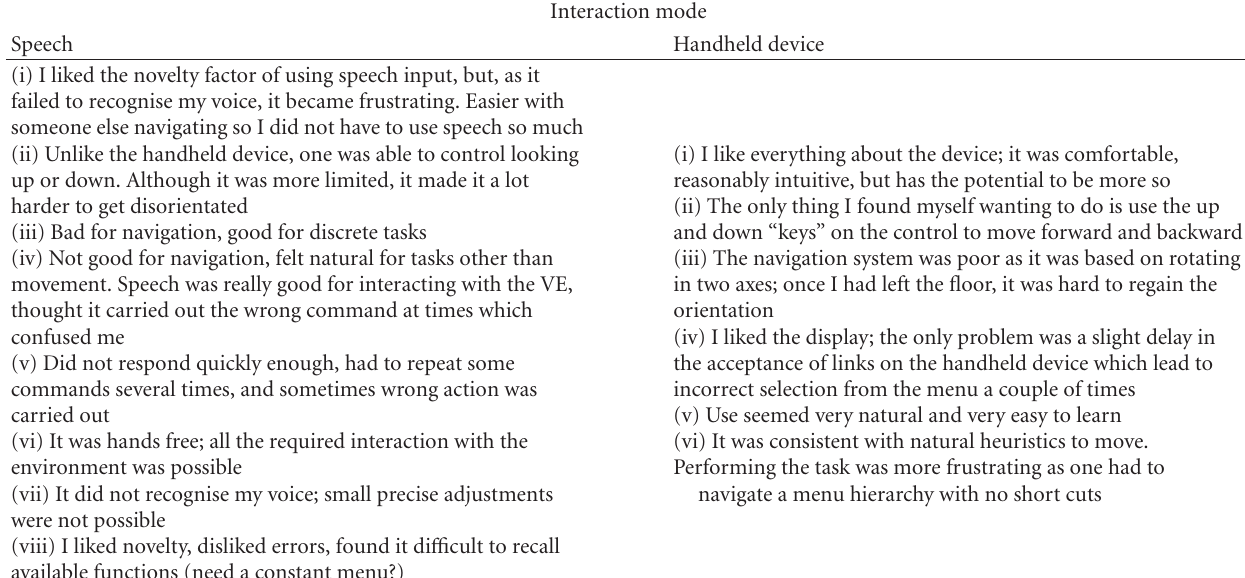
Table 3: Input device usability